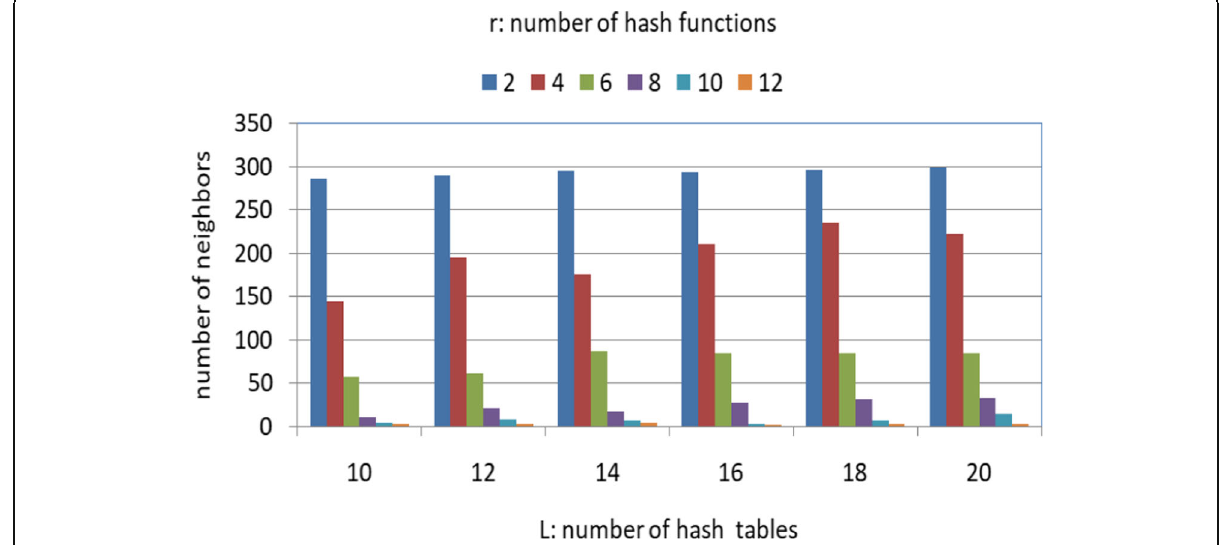
Fig. 4 Number of neighbors in Rec LSH* (w.r.t. r and L ). Detailed legend: r : number of hash functions (2, 4, 6, 8, 10,